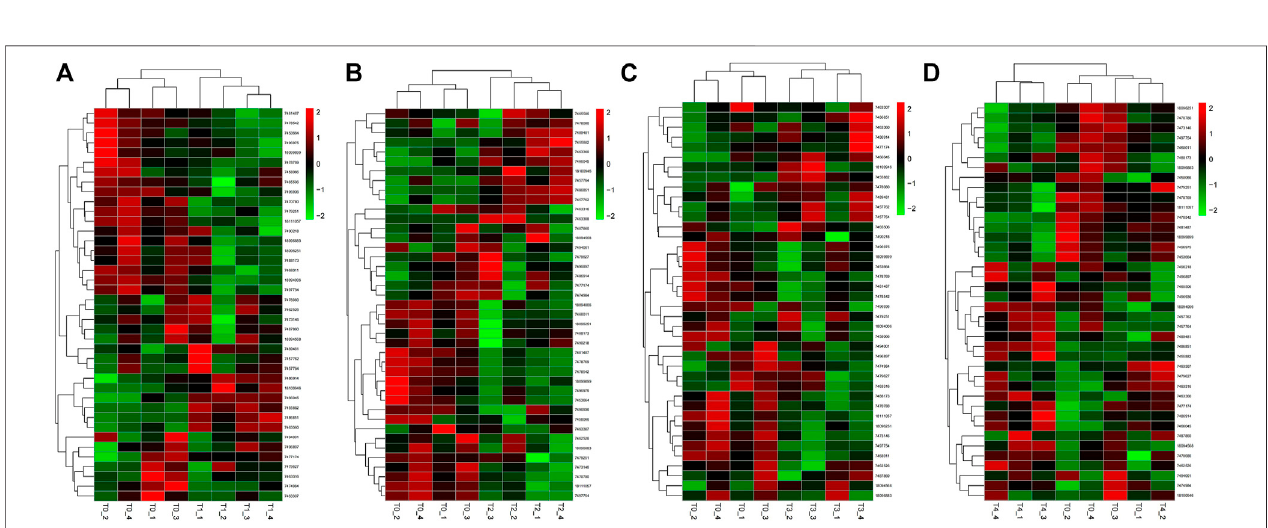
FIGURE 10 | Heatmaps of DEGs in response to F. oxysporum stress under different treatments. (A) The heatmap of DEGs in response to F. oxysporum stress at 6 h. (B) The heatmap of DEGs in response to F. oxysporum stress at 12 h. (C) The heatmap of DEGs in response to F. oxysporum stress at 24 h. (D) The heatmap of DEGsinresponseto F.oxysporum stressat48 h.Clusteranalyseswerebasedonlog 2 FPKM.Redboxesrepresenthighlyexpressedgenes.Greenboxesrepresentlow expressed genes. The left side represents gene clusters. T1, T2, T3, and T4 indicated that PdPap were infected by F. oxysporum for 6, 12, 24, and 48 h.